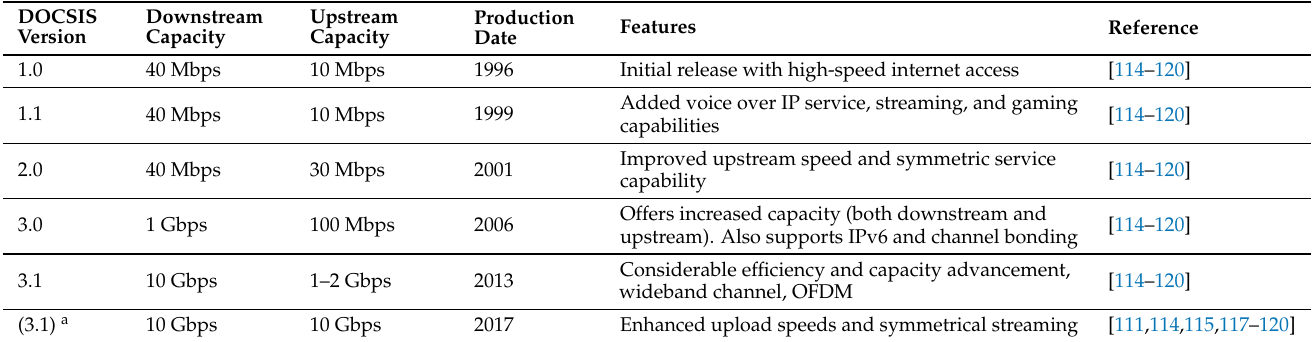
Table 1. DOCSIS evolution.